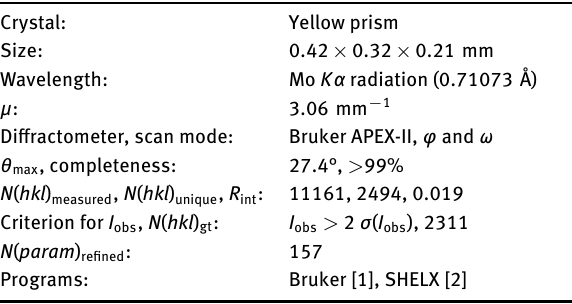
Table 1: Data collection and handling.